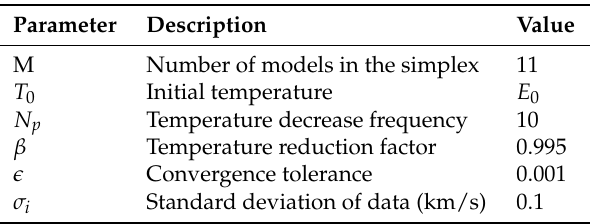
Table 1. Values of the parameters used in the ASSA